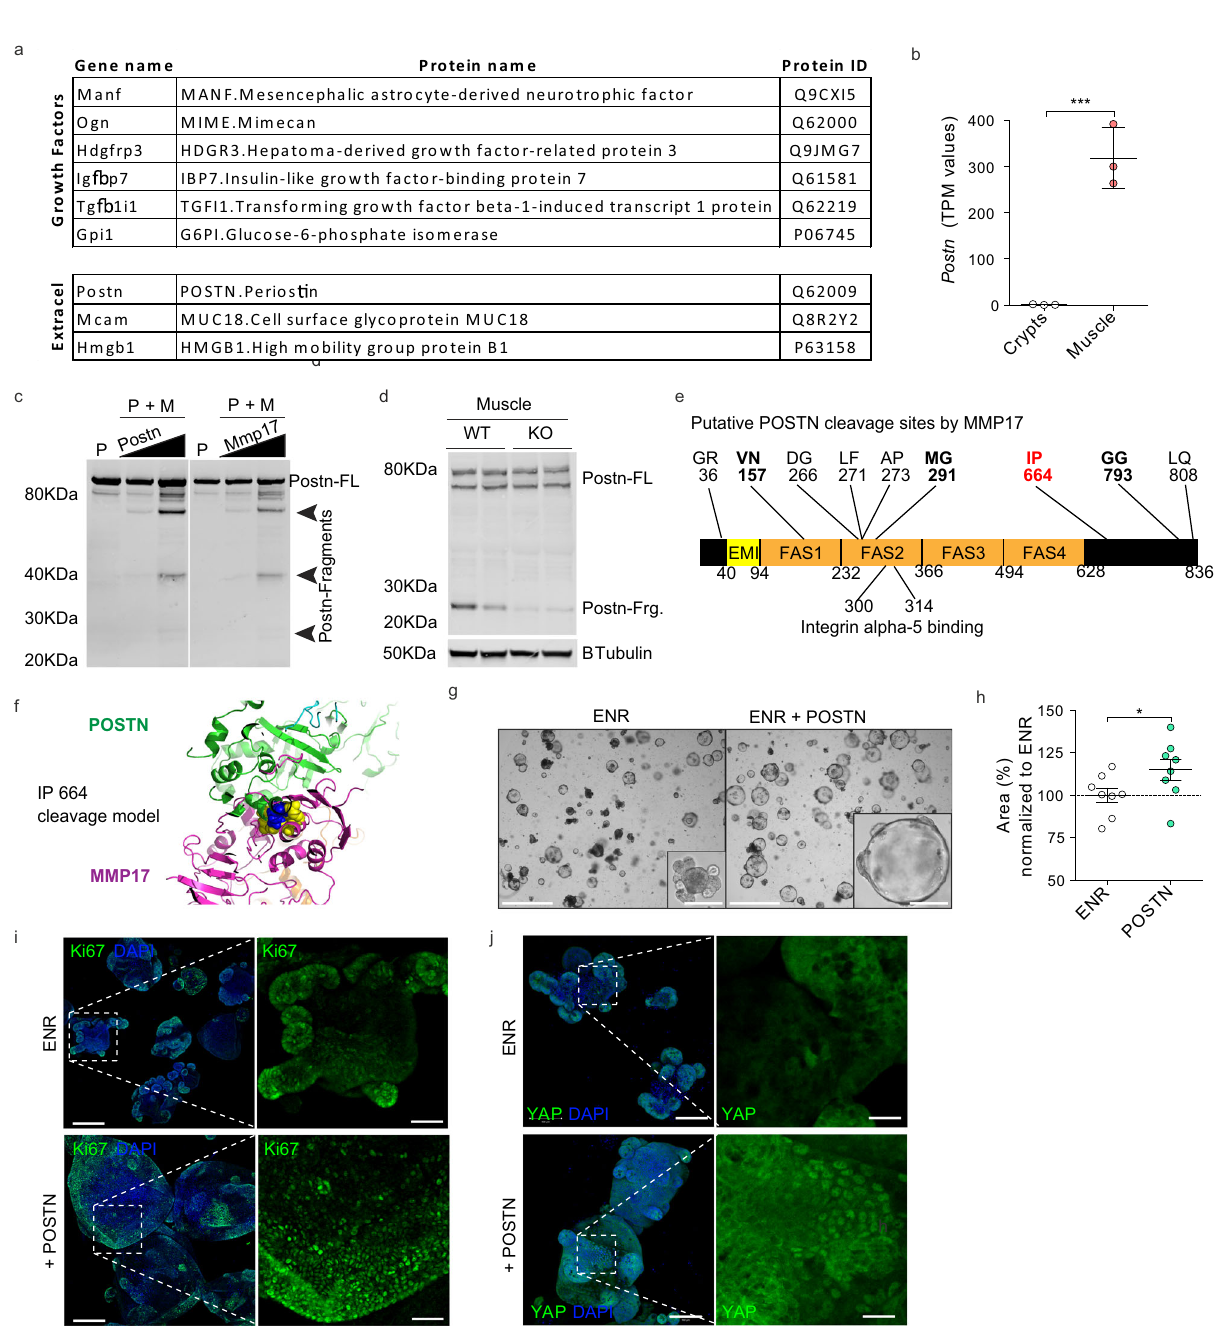
Fig. 8 Identi fi cation of smooth muscle-derived factor PERIOSTIN as an in vivo and in vitro substrate for MMP17. a List of growth factors and extracellular proteins found in muscle-SN. n = 3 biological replicates. b TPM values for Postn comparing crypts with smooth muscle tissue. n = 3 biological replicates. c In vitro digestion experiment with human recombinant proteins showing POSTN fragments when in contact with MMP17 catalytic domain. P, POSTN, M, MMP17, FL, full length. n = 2 experiments with increasing concentrations of POSTN or MMP17. d WB of mouse intestinal muscle showing decreased POSTN fragments in the absence of MMP17. n = 2 biological replicates. e Scheme of POSTN molecule showing putative sites of MMP17 cleavage based on digestion assays followed by MS. Sites that are noted all had 5 or more peptide-spectrum matches (PSMs). In blue and red are available sites after in silico modeling (see Fig. 8f for a model of the best fi tted (red) site). f In silico model of MMP17 (magenta)- POSTN (green) docking showing close proximity of 664-665 POSTN cleavage site (cyan) to MMP17 catalytic site (yellow). g , h Representative bright fi eld images showing SI organoids morphology in the presence of POSTN and area quanti fi cation in ( h ) (Day 3). Scale 1250 and 200 µ m in inset. n = 8 wells/genotype pooled from three independently performed experiments with 2 – 3 wells/experiment. i , j Representative confocal maximum intensity projection images showing YAP or Ki67 (green) staining in POSTN-treated SI organoids. Scale 100 µ m; 25 µ m in inset (YAP pictures) and 200 µ m and 100 µ m in Ki67 pictures. Numerical data are means ± SD. Data in ( b ) represents p -adjusted value from RNAseq analysis (padj value of 1.02e − 06), and data in ( h ) was analyzed by Mann – Whitney test (two-sided, p = 0.0260). Source data are provided as a Source Data fi